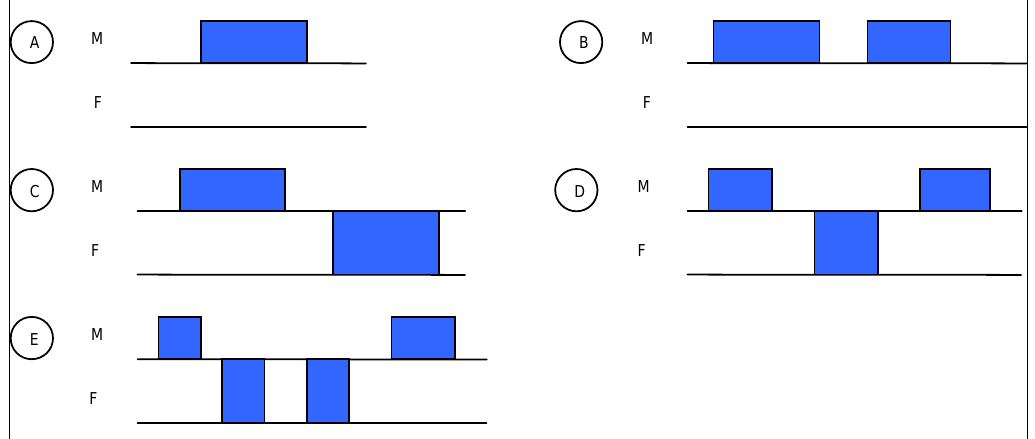
Figure 3. Examples of Distinguished